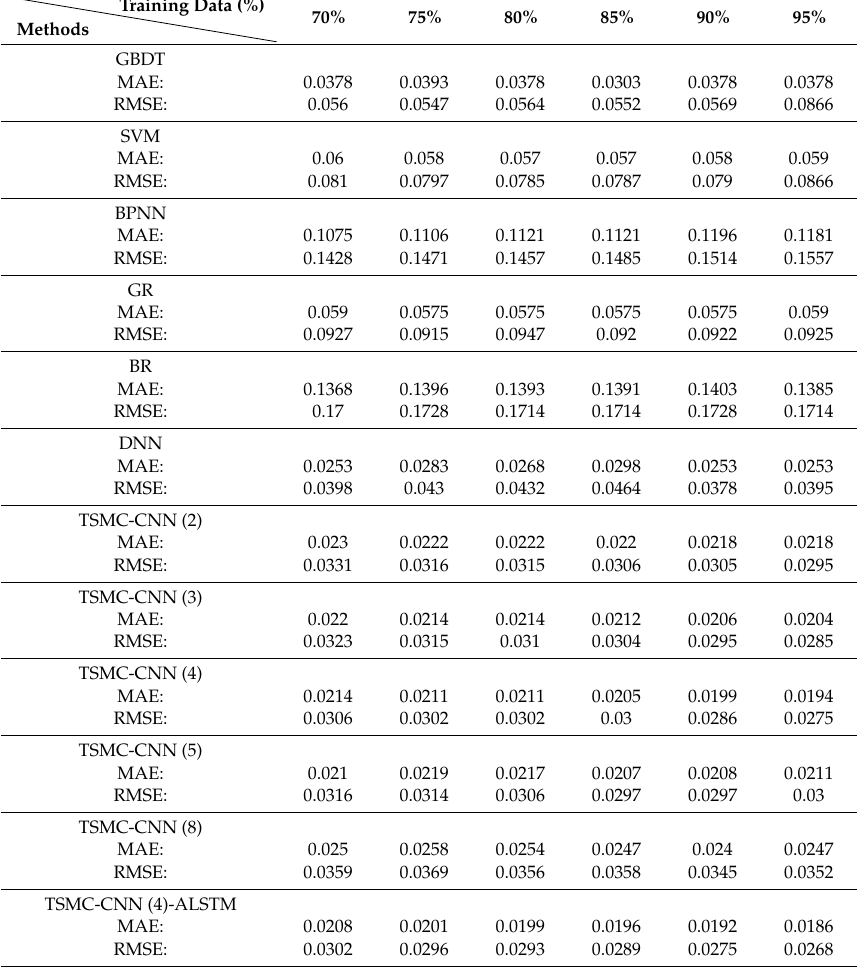
Table 3. Comparisons of the proposed methods with related methods.